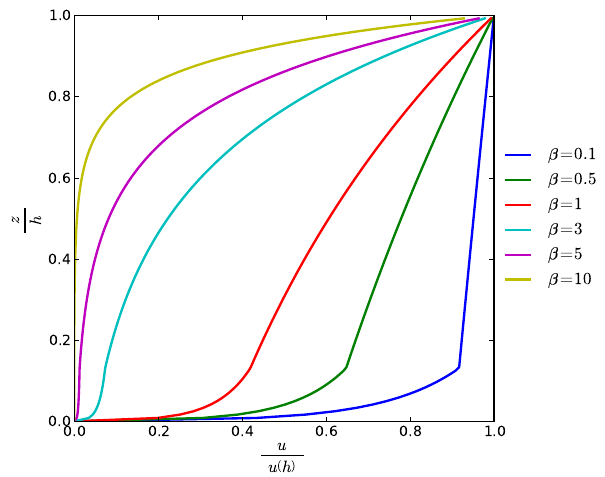
Figure 5. Wind velocity profiles modified to fit the logarithmic pro- file close to the surface ( (cid:56) = 0 . 2).